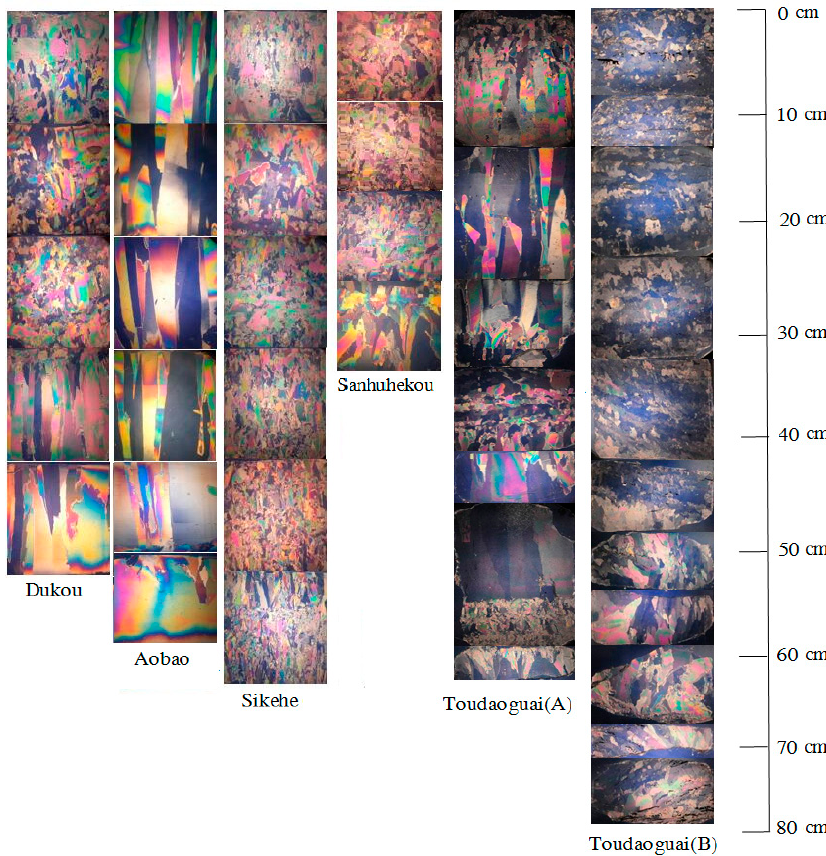
Figure 7. Ice microstructure at different points along the Yellow River.